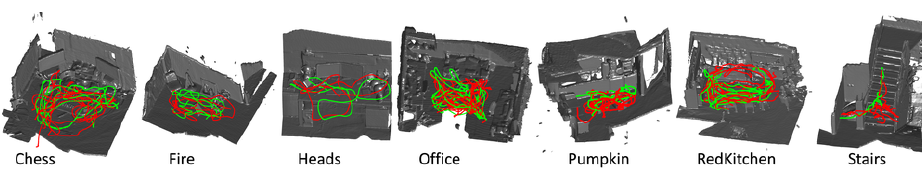
Figure 5. 7 Scene dataset [29].